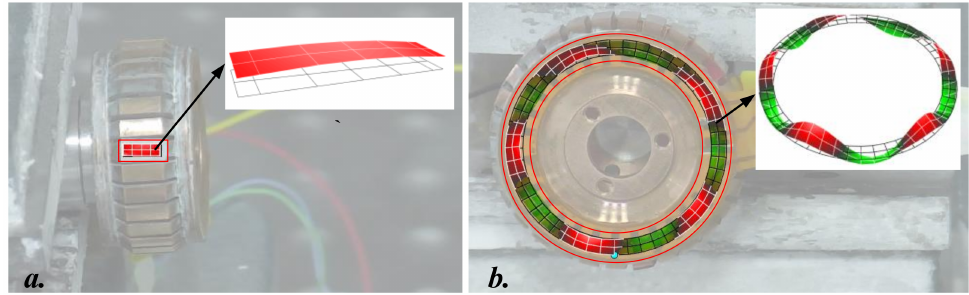
Figure 8. Vibration scanning results of the stator: ( a ) vibration shape of one tooth surface; ( b ) vibration shape of the stator end